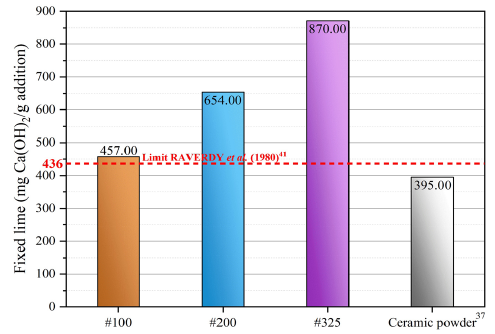
Figure 9. Modified Chapelle Test.